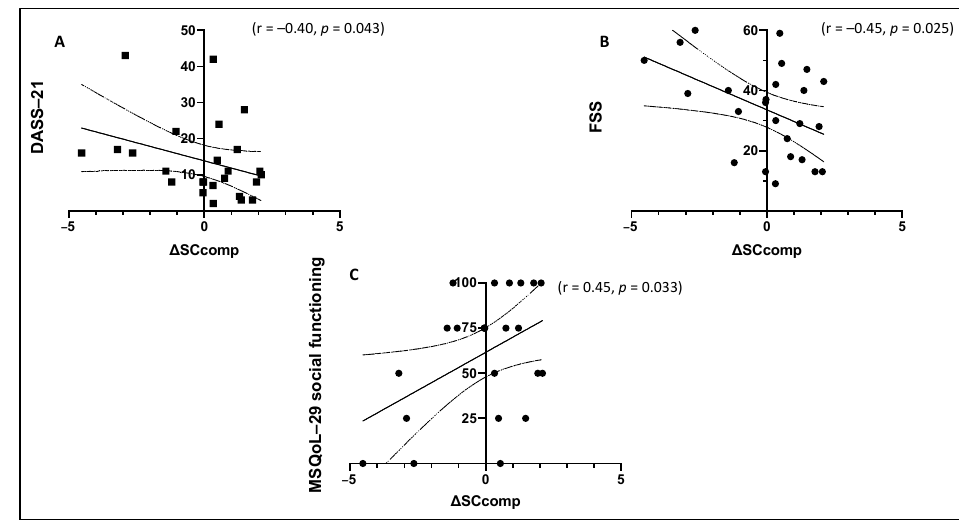
Figure 4. Significant association between ΔSCcomp and, respectively, DASS-21 global score ( A ), FSS global score ( B ), and MSQoL-29 social functioning ( C ). ΔSCcomp = change in social cognition composite score; DASS-21 = Depression Anxiety and Stress Scale-21; FSS = Fatigue Severity Scale; MSQoL-29 = Multiple Sclerosis Quality of Life-29.